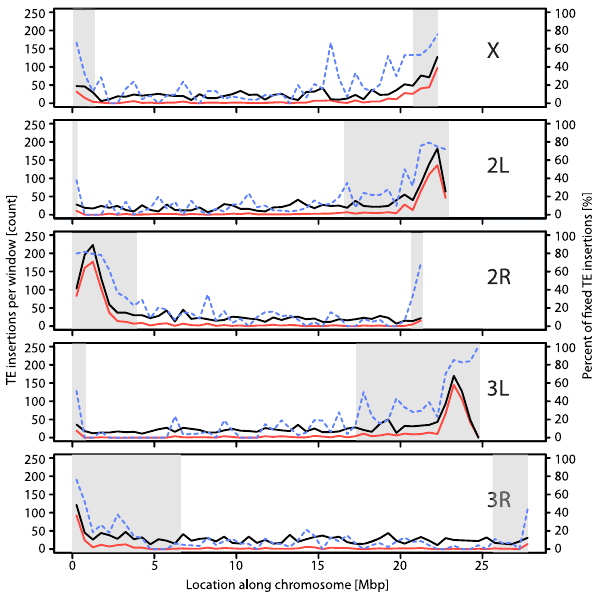
6.1 Figure 2. Distribution of all (black), fixed (red) and percentage of fixed (dashed blue) TE insertions in our natural population of D.melanogaster . The total number of TE insertions in a sliding window of 500 kb is plotted against the position in the five major chromosome arms of D. melanogaster . Shaded grey areas represent regions with a low recombination rate ( , 1 cM/Mbp).